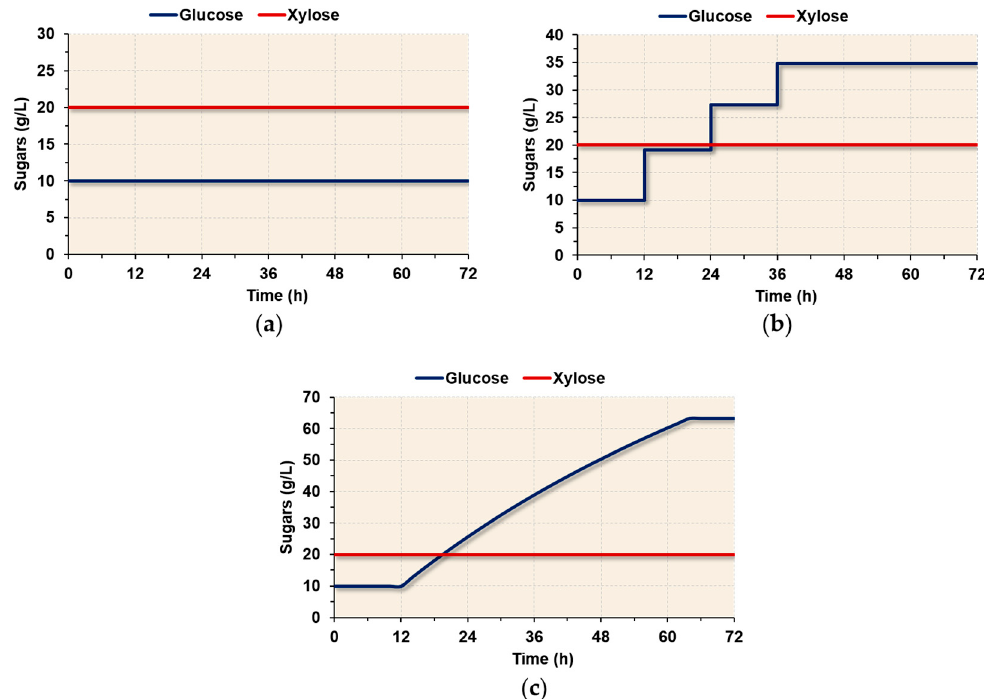
Figure 1. Simulation of sugars present during lignocellulose bioethanol production with different configurations. Illustrations of the glucose and xylose concentrations as a function of time during: ( a ) batch sequential, separate hydrolysis and fermentation (SHF) fermentation, ( b ) SHF + fed-batch simultaneous saccharification and fermentation (SSF) fermentation and ( c ) SSF fermentation. It should be noted that the actual sugar concentration in the reactor depends on the extent of microbial conversion in each case (not simulated here).